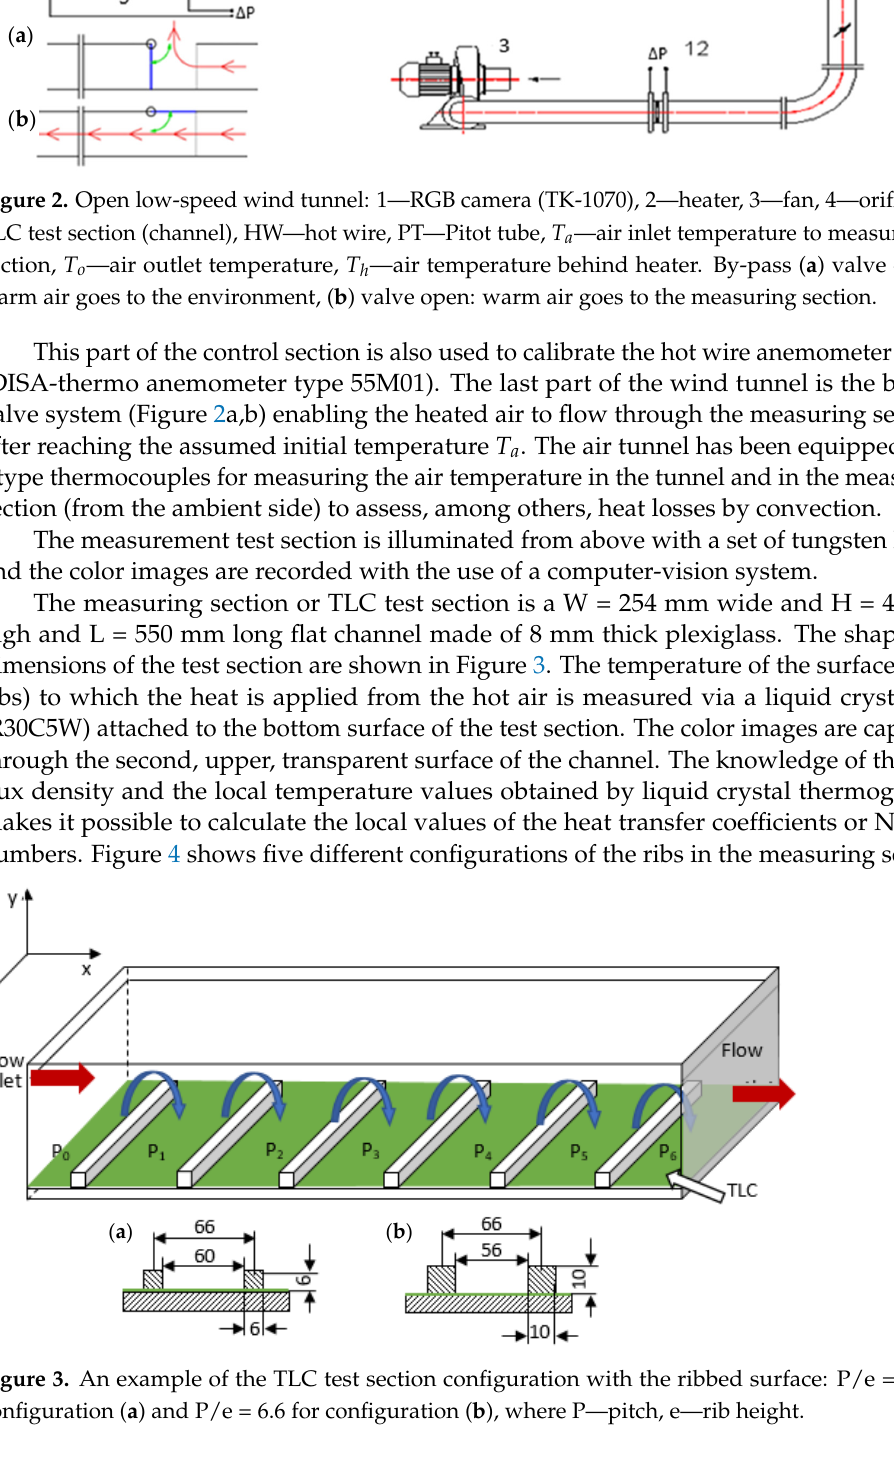
Figure 4. Diagram of ribbed sections: ( a ) configurations_1 and _6, ( b ) configurations_2 and _7, ( c ) configurations_3 and _8, ( d ) configurations_4 and _9, ( e ) configurations_5 and _10. (1) configuration_1 (6 mm straight bottom): only the bottom wall of the duct ribbed with six ribs 6 mm wide and square cross-section; ribs perpendicular to the direction of incoming air; distance between rib centers: 66 mm (60 mm between rib edges), P/e = 11; (2) configuration_2 (6 mm straight bottom-up): bottom and top wall of the duct ribbed with six ribs (each wall) 6 mm wide and square; ribs perpendicular to the direction of incoming air; distance between rib centers: 66 mm (60 mm between rib edges) P/e = 11;